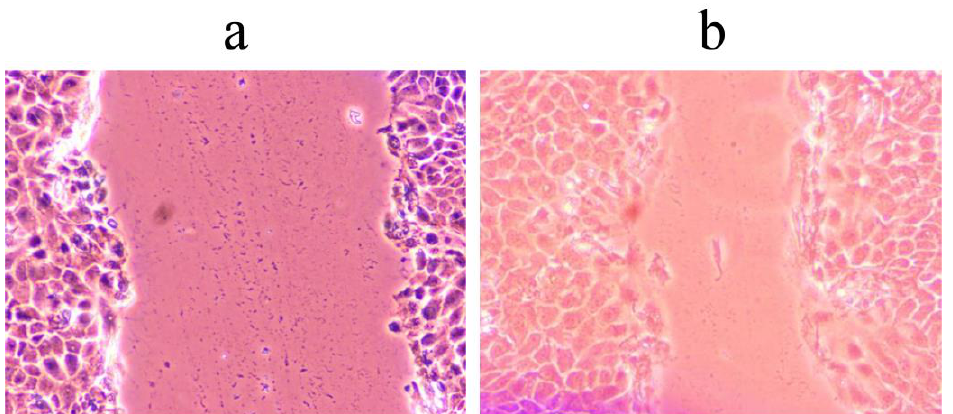
Figure 3. Representative images of wound closure assay in HaCaT cells treated with Cs3 extract at ( a ) the beginning of measurement (0 h) and ( b ) the final measurement (after 48 h) taken under magnification 10 x and optical zoom 33%.